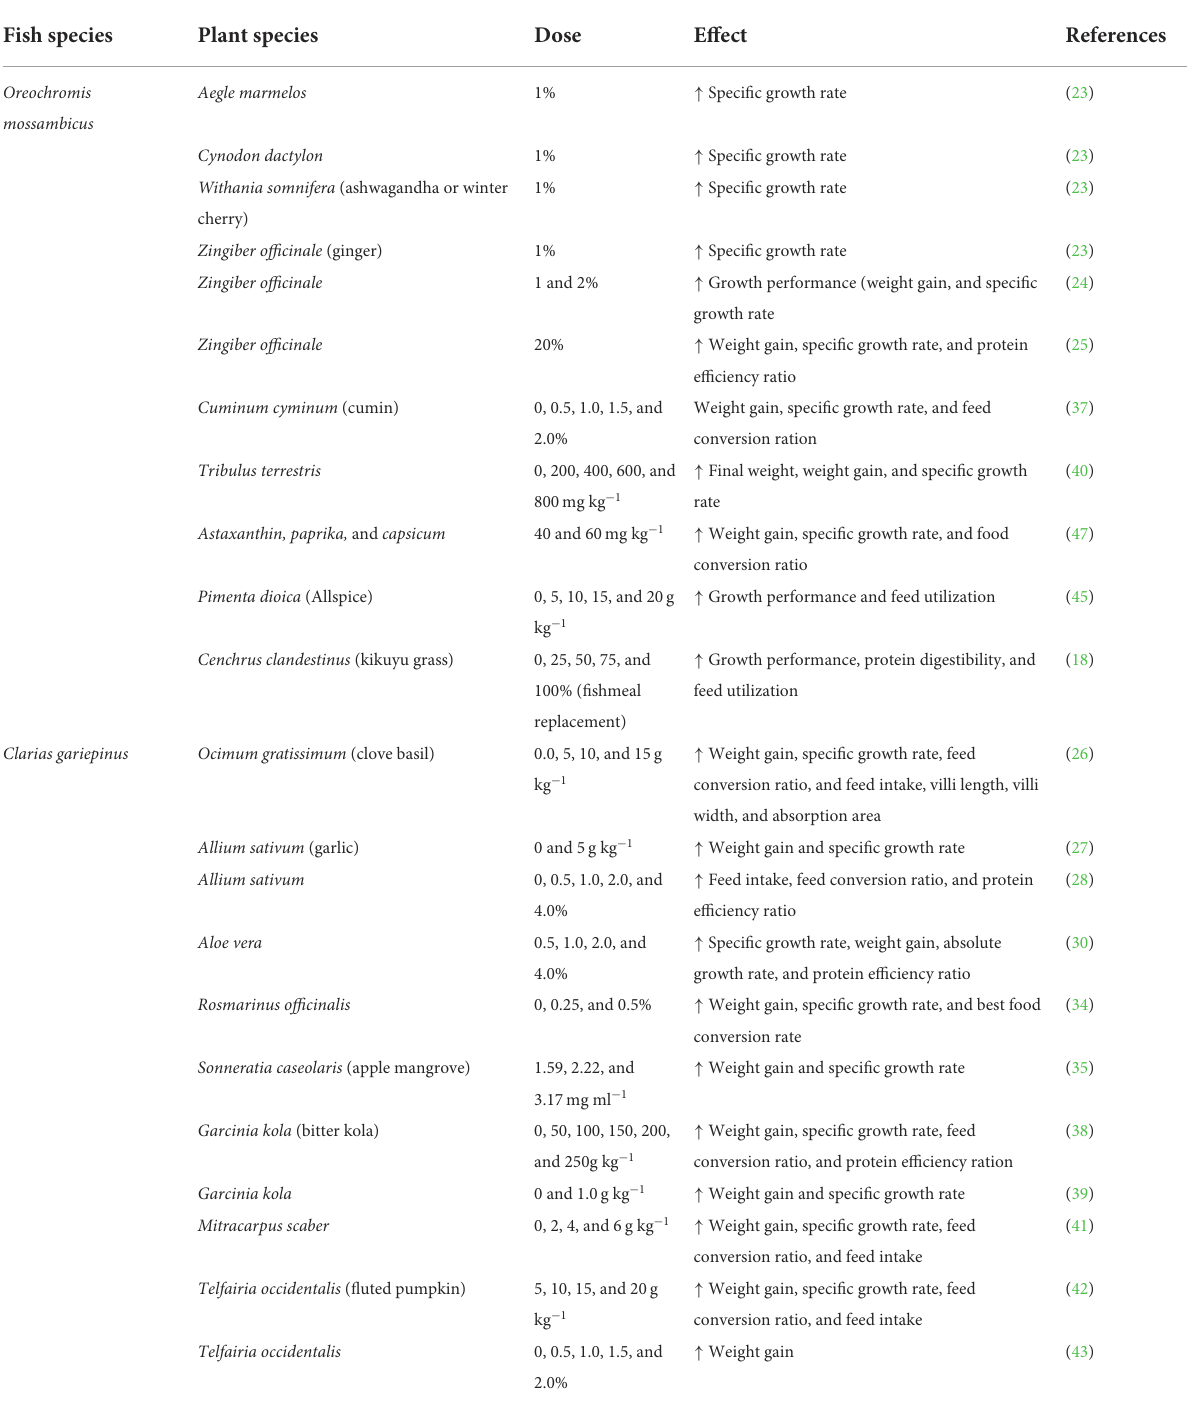
TABLE 1 Plants used to promote growth performance in Oreochromis mossambicus and Clarias gariepinus . Fish